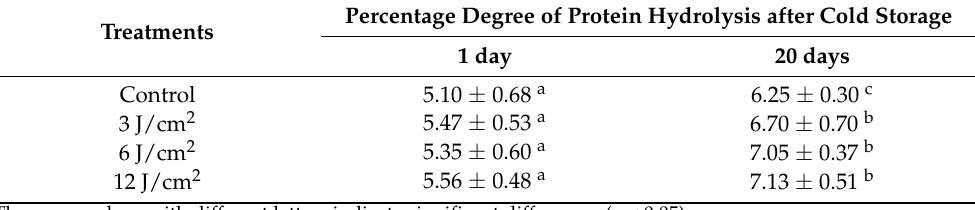
Table 4. Proteolytic activity of the crude extract collected from different labneh treatments. Treatments